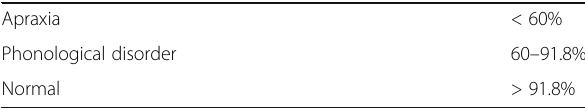
Table 8 Total scores of CAS test battery Apraxia < 60% Phonological